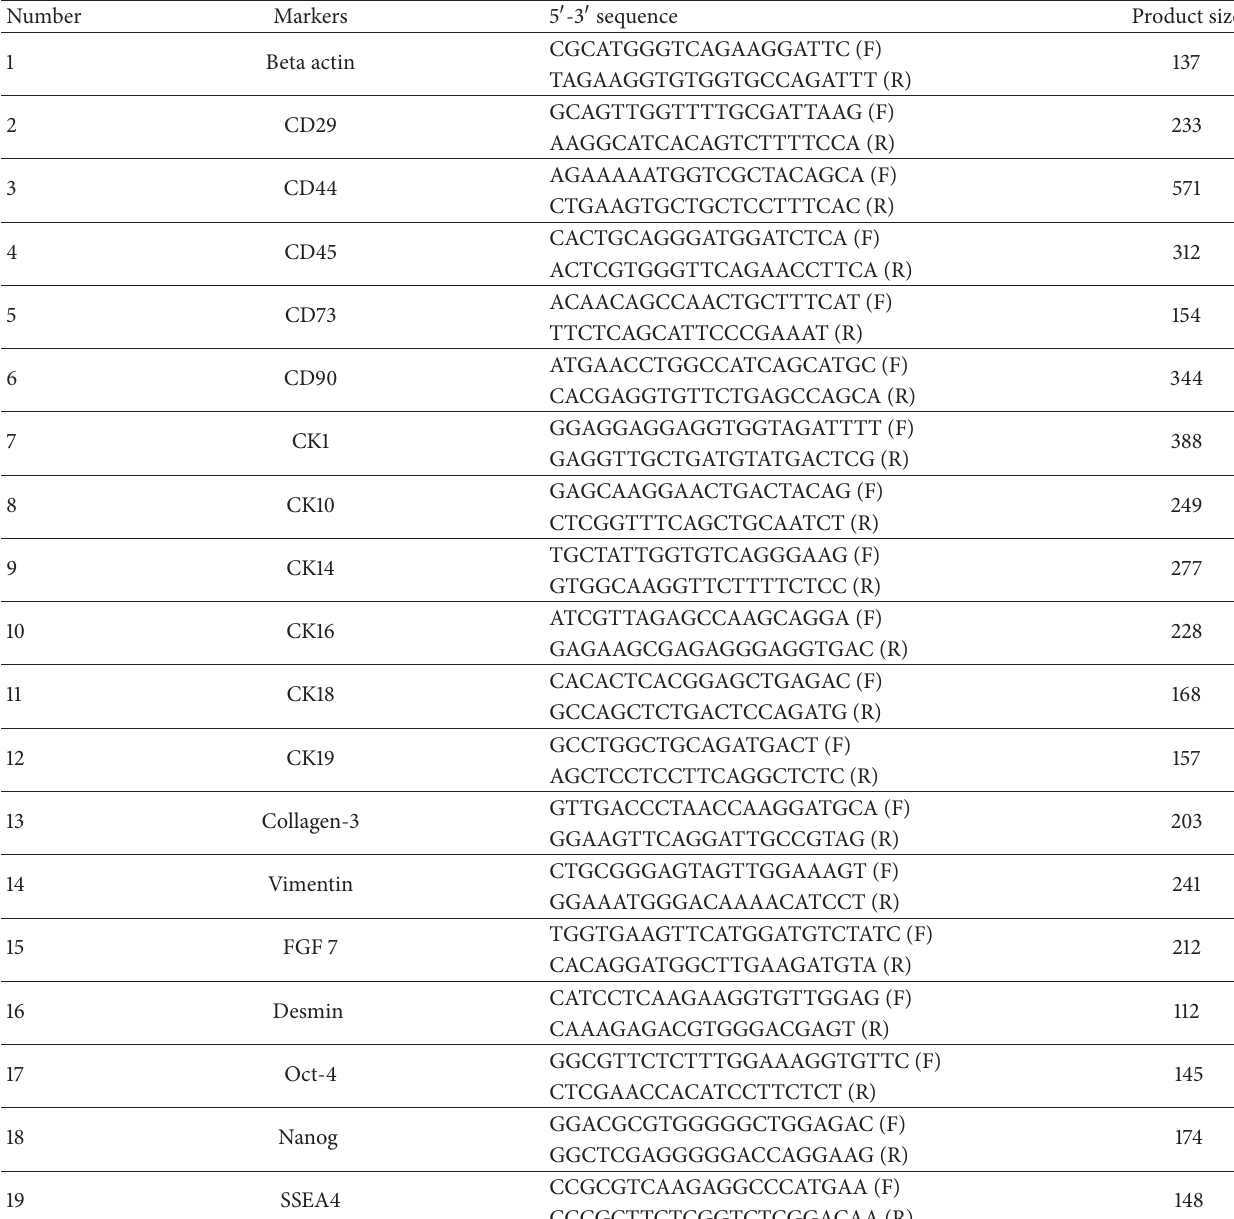
Table 1: List of used primers and their